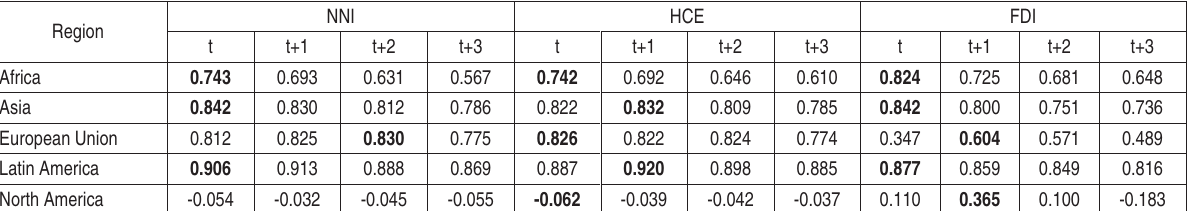
Table 2. The results of lag correlation determining between access expansion to the credit unions services and financial and economic parameters